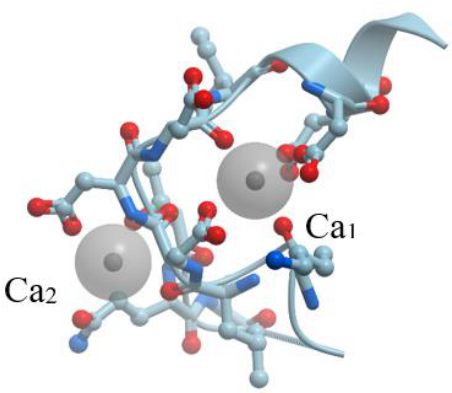
Figure 2. X-ray structure of the primary and secondary Ca 2 + - binding sites in human α -lactalbumin (PDB ID: 1a4v). Gray spheres represent calcium ions bound in the strong primary (Ca 1 )- and the weak secondary (Ca 2 )-binding sites.